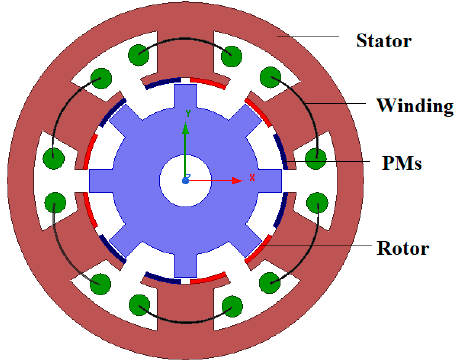
Figure 10. Typical topologies of FRM: ( a ) consequent-pole permanent magnet (CPM)-FRM); ( b ) stator- mounted permanent magnet (SMPM)-FRM [27,28].